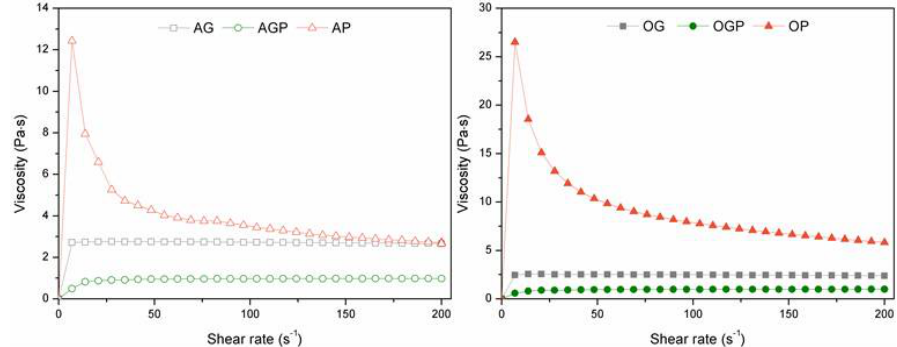
Figure 4. Bio-polyols viscosity curves.